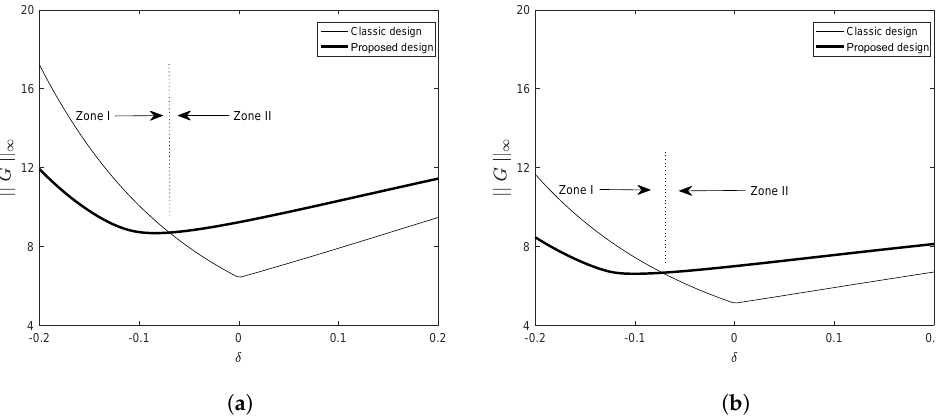
Figure 11. Evolution of peak vibration amplitude ∥ G ∥ ∞ against actual stiffness uncertainty δ changing within the interval [− β , + β ] , for an uncertain primary system controlled by means of ( a ) a TMD and ( b ) a TMDI. The set of parameters used for the simulation was µ = 0.05, ν = 0.03, and β = 20%. Thin solid lines: using the classic equal-peak design; thick solid lines: using the proposed